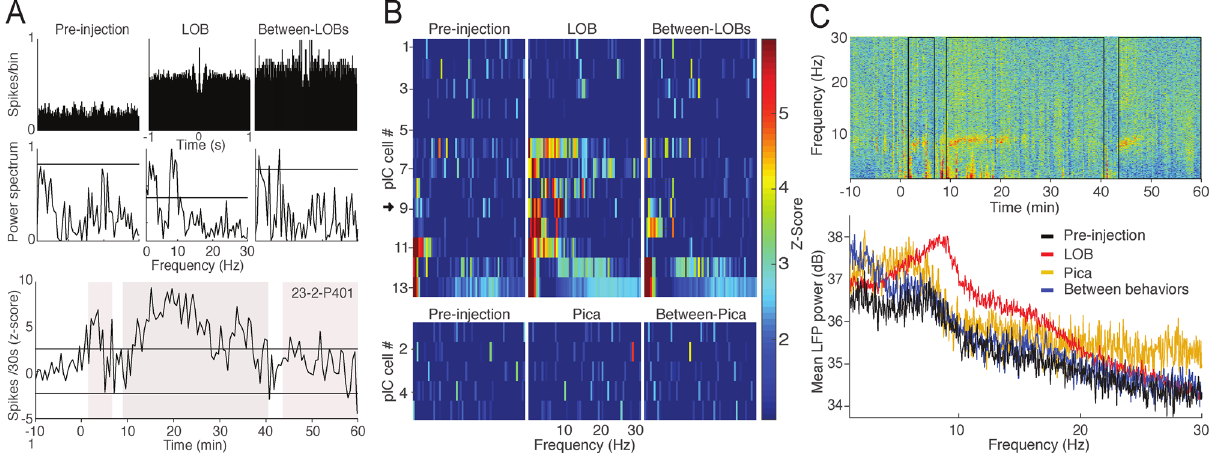
Figure 5. Low frequency activity in spikes and field potential associated with LOB. ( A ) Normalized auto- correlograms and power spectrum plots for pre-injection, LOB and between-LOB periods (not including Pica epochs) of the PSTH shown below, where the shaded regions depict three LOB periods. Horizontal line on the power spectrum plots represents two standard deviations from the averaged magnitude. ( B ) Spectrograms for all thirteen and five neurons whose firing rate increased significantly during LOB and Pica, respectively. ( C ) Spectrogram of LFP signal from one channel of a tetrode used to record single units, showing activity associated with LOB (same experiment shown in A ). The rectangles enclosed by black lines depict the three LOB episodes shown in ( A ) Below, the averaged power spectrum of five LFP signals recorded in the pIC of four rats. Between- LOB periods do not include Pica